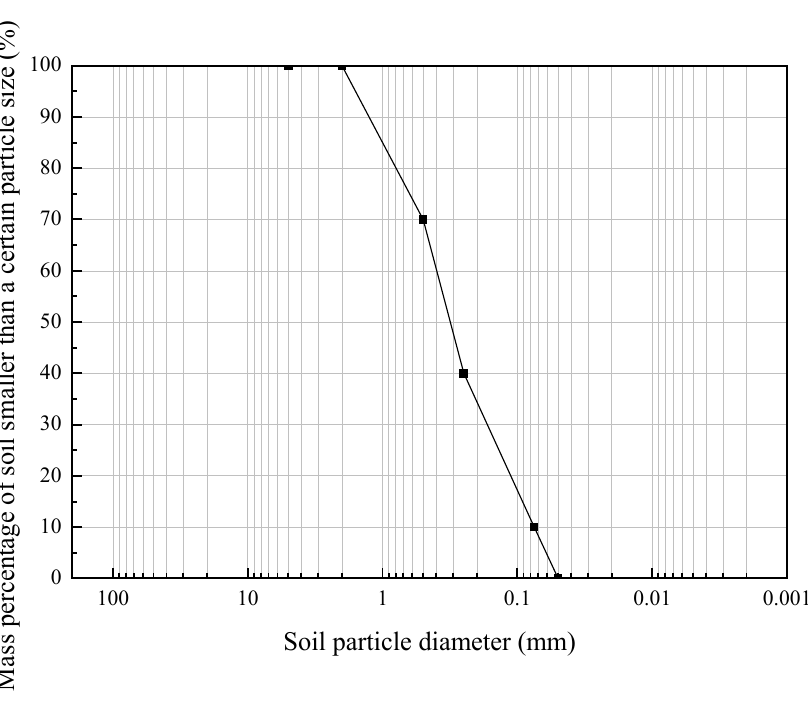
Figure 11. Soil particle size distribution curve.